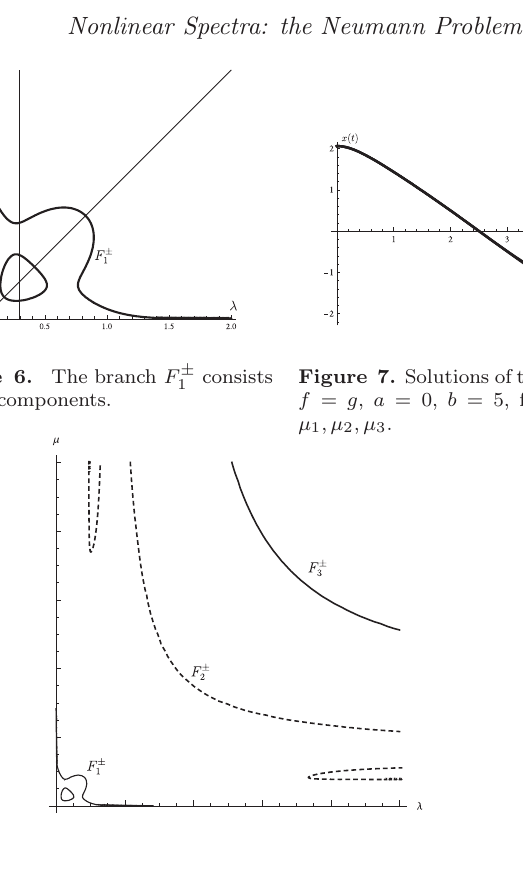
Figure 8. The first three branches of the spectrum